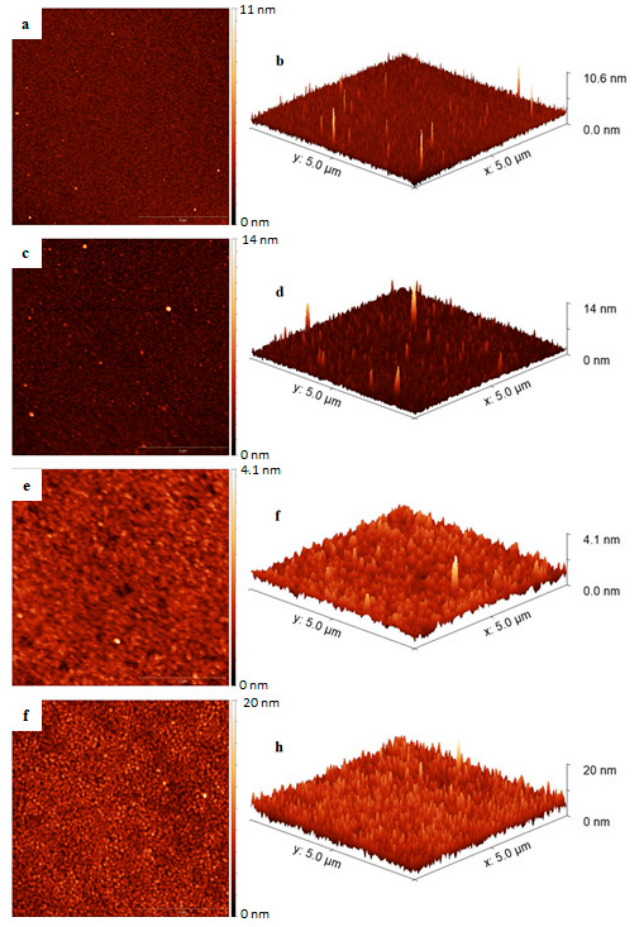
Figure 2. Atomic force microscopy (AFM) images of TiN thin films: ( a – b ) S1, as-grown, ( c – d ) S2, annealed at 300 ° C, ( e – f ) S3, annealed at 500 ° C, ( g – h ) S4, annealed at 700 ° C. Table 1. Root mean square (RMS) surface roughness, average grain size as measured by AFM im- ages, optical, and electrical properties of TiN films.